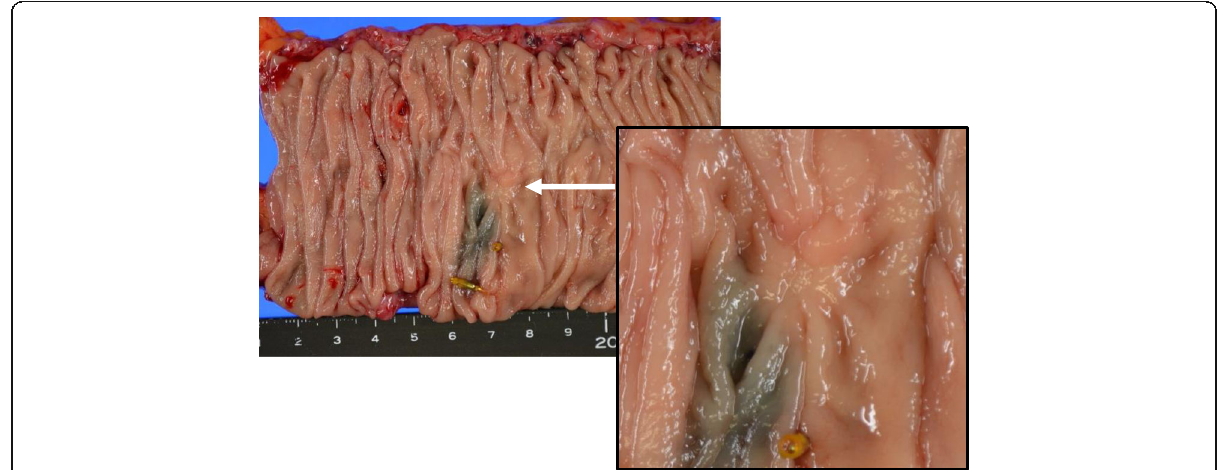
Fig. 3 The resected specimen showed only a scar near ink-injected site, but no tumor lesion was detected. Only a scar-like lesion was